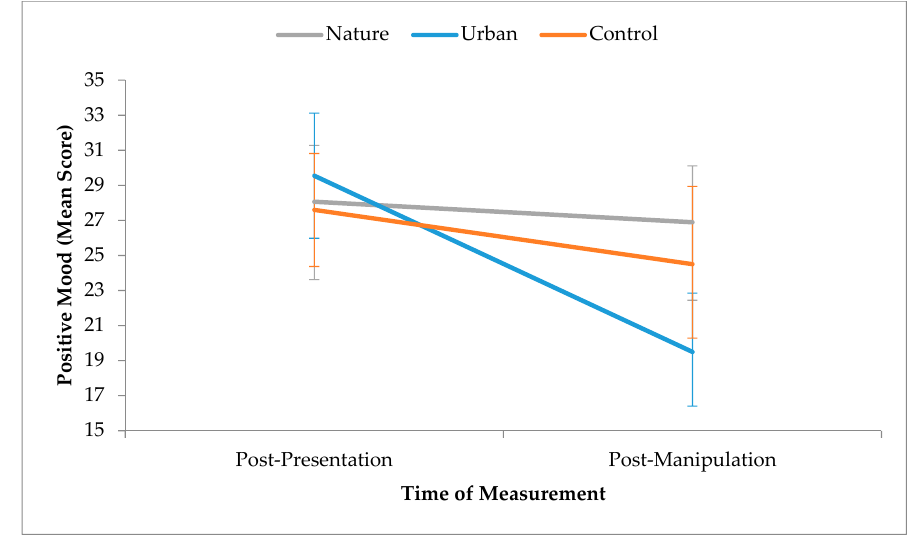
Figure 4. Time x Condition interaction effects for positive mood. Error bars represent 95% confidence intervals.